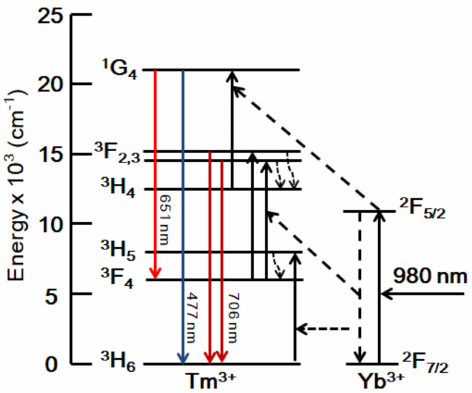
Figure 4. Schematic diagram of upconversion luminescence mechanism in Tm 3+ /Yb 3+ co-doped LNT glasses excited at 976 nm